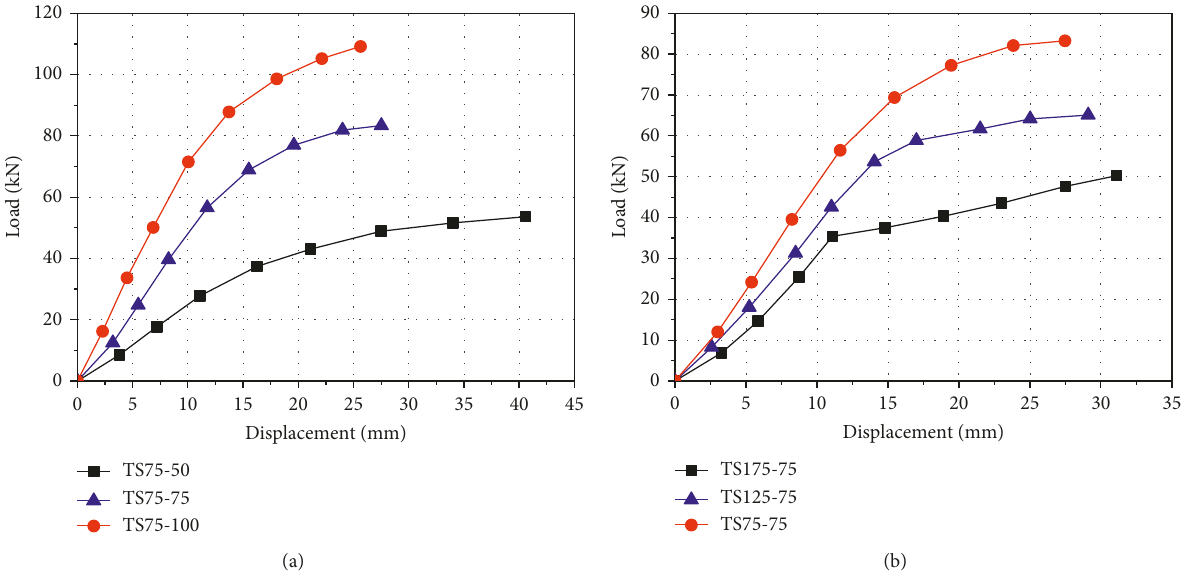
Figure 9: Load-midspan deflection curves of specimens (a) with different web heights and (b) with different web spacing